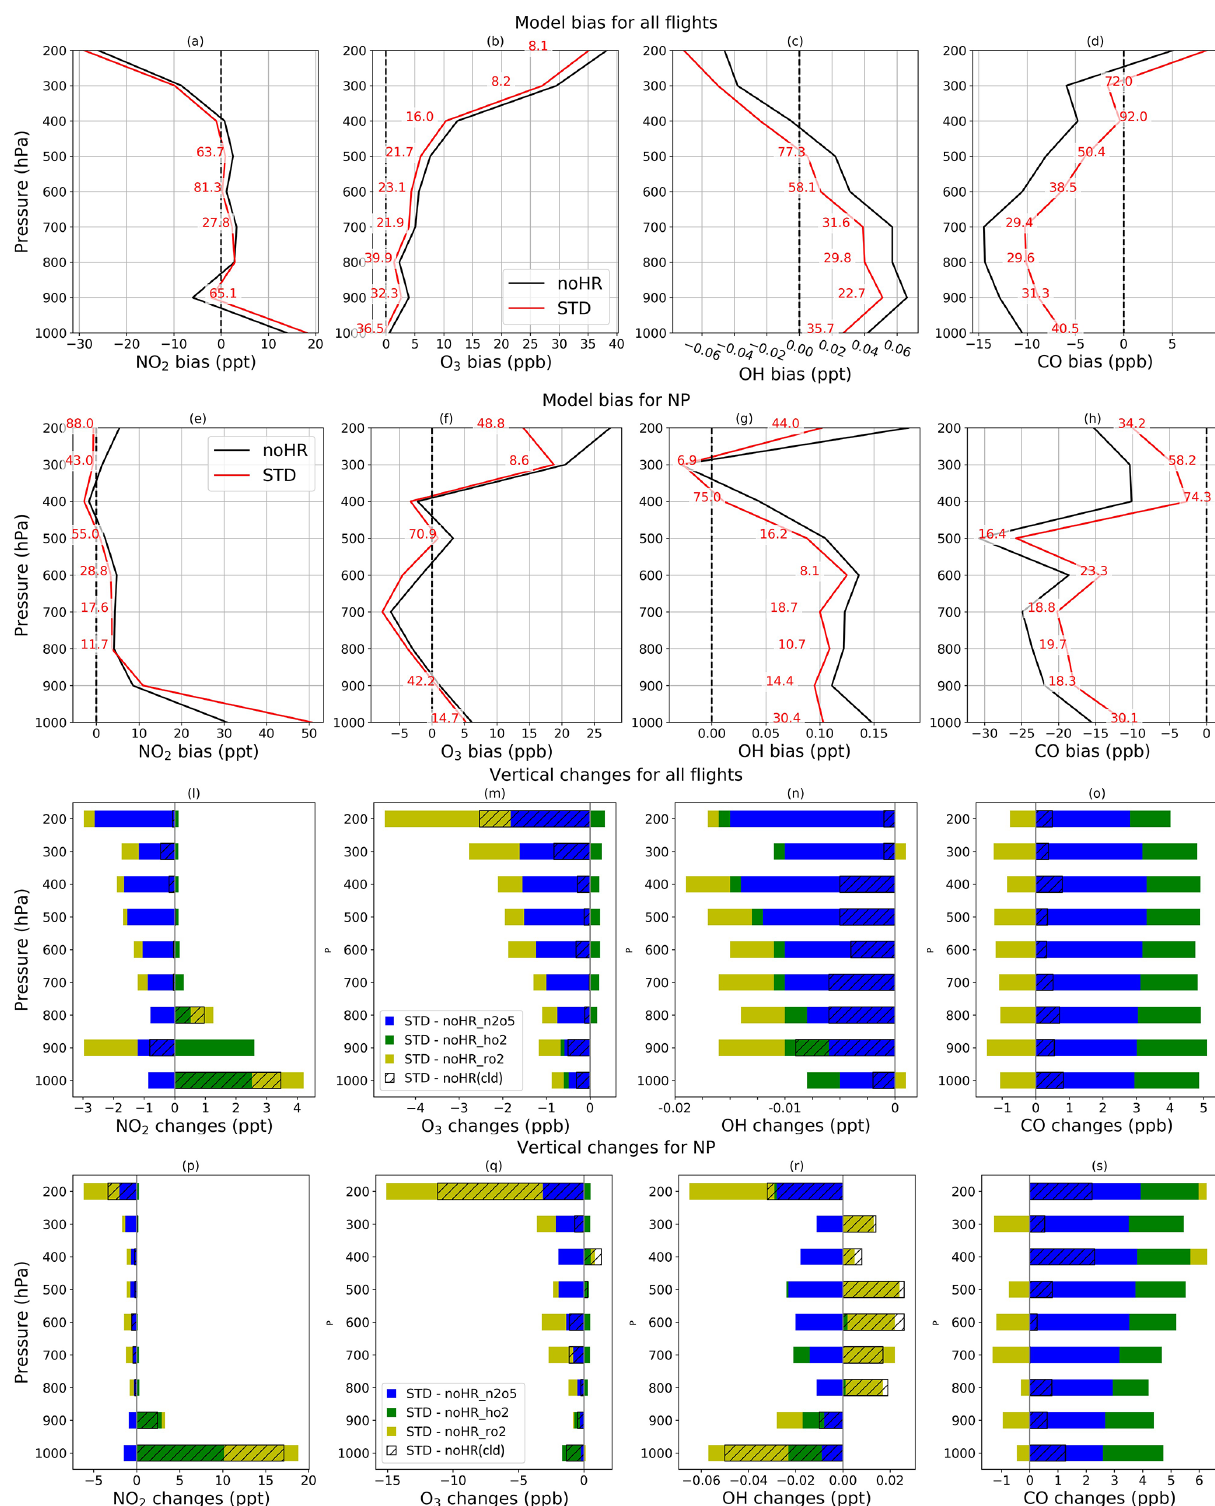
Figure 6. Vertical bias against ATom1 (a–h) and vertical HR effects (l–s) . Data for each pressure level P are calculated within the range of P ± 50hPa, with the applied three-sigma-rule for outlier detection. All rows show calculations for all flight domains the and the North Pacific region. The horizontal axis shows model bias and absolute changes with units written in each panel. The vertical axis shows pressure (hPa). The red numbers in (a) – (h) represent relative reductions (%) of the STD run’s bias compared to that of the noHR run.